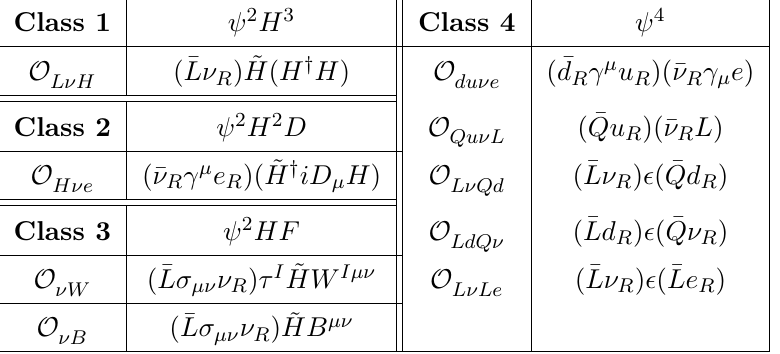
Table 1 . Dimension-six operators involving one sterile neutrino field ν R . Each fermion field has a generation index, except ν . When needed, we shall attach these indices to the operator R